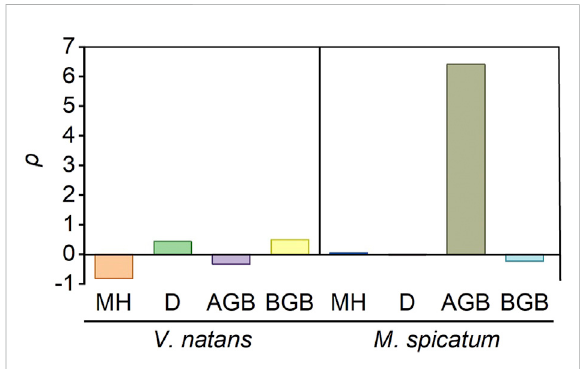
FIGURE 5 The interaction statistic ρ of two submersed macrophytes. MH, maximum height, cm; D, density, ind. m − 2 ; AGB, above- ground biomass, g m − 2 . BGB, below-ground biomass, g m − 2 . Y F , Y N , Y C and Y FN are biomass of the treatment with stressor fi sh (F) only, stressor nitrogen (N) only, no stressors (control -C), and both stressors (F and N), respectively. ρ > 0 indicates synergistic effect, ρ = 0 indicates additive effect, and ρ < 0 indicates antagonistic